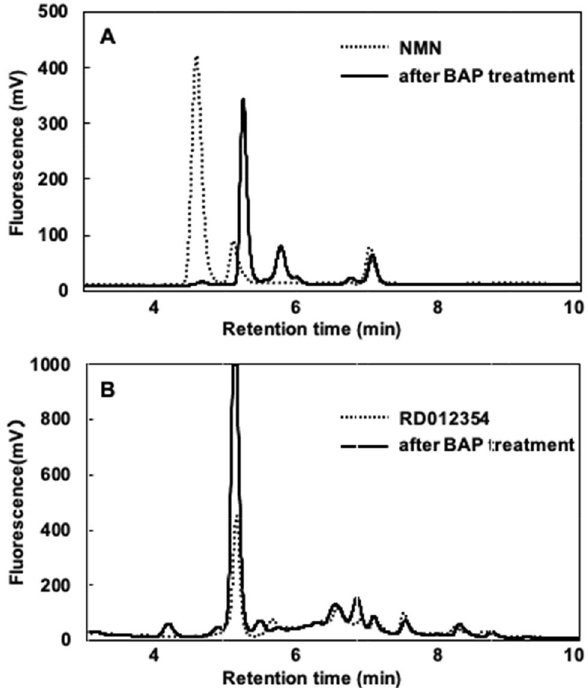
Figure 2. Dephosphorylation of NMN to produce NR by BAP. ( A ) 0.3 nmol of NMN was incubated with 3 U of BAP at 37 °C for 12 h, which underwent fluorescent derivatization, followed by HPLC analysis. ( B ) After 15 ml of the culture filtrate of RD012354 was treated with BAP under the same conditions, NR fraction was extracted with PBA resin and HPLC analysis was performed as described above. Dotted and solid lines represent NR analysis before and after BAP treatment,